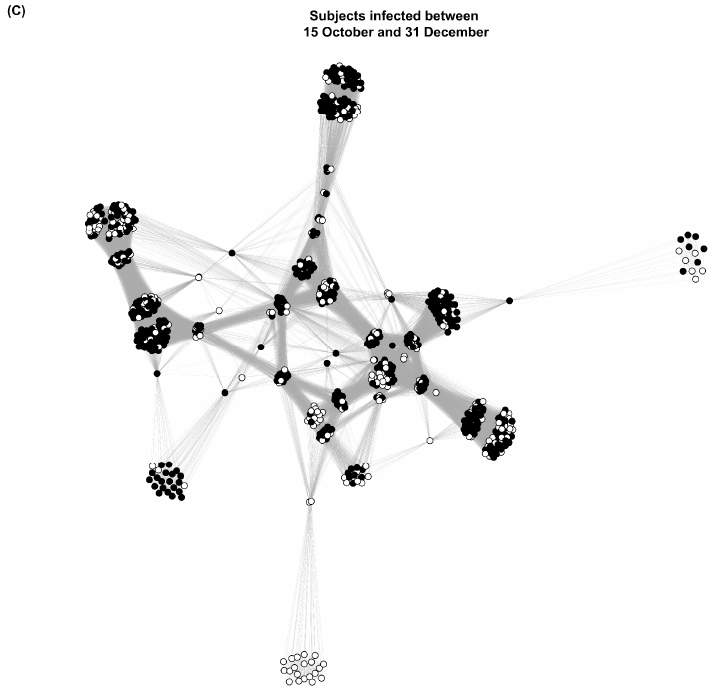
Figure 2. Network analysis graphs of SARS-CoV-2 transmission in the Community of “San Patrignano”. Links between subjects (nodes) are given by living and working areas. Panel ( A ) shows the network by living areas. In panel ( B ) , the individuals who became infected between the outbreak onset (15 October 2020) and the observed peak (17 November 2020) are shown in black. In panel ( C ) , all individuals who became infected by 31 December 2020 are shown in black.